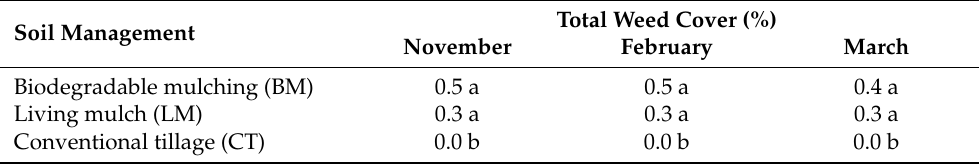
Table 4. Effects of soil management systems on total cover of weeds 1